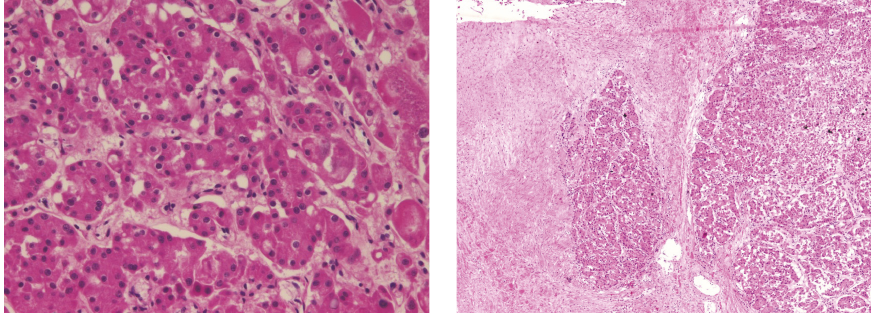
Figure 1: Pathology pictures.